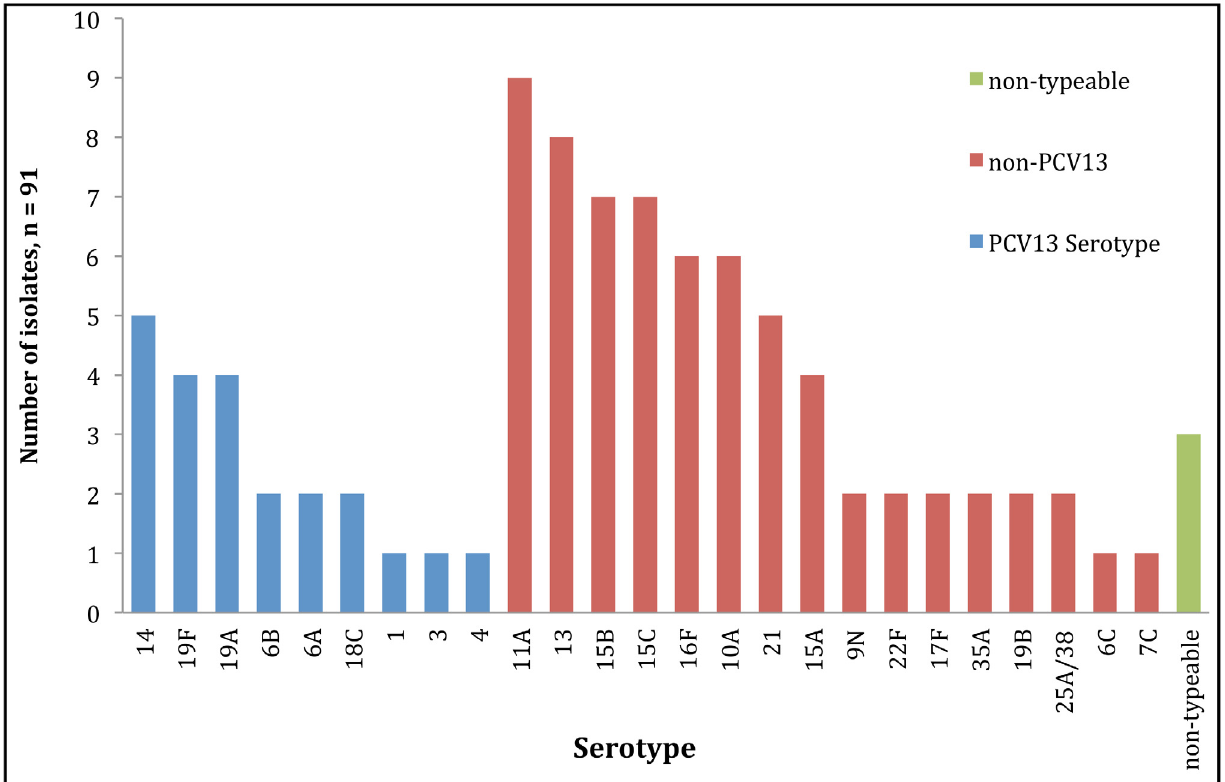
Fig 2. Serotype distribution of nasopharyngeal pneumococcal isolates. The figure includes serotypes detected from the Drakenstein Child Health Study, determined by Quellung reaction, excluding duplicate serotypes from the same infant. Blue = serotypes included in PCV13; Red = serotypes not included in PCV13. Green = non-typable